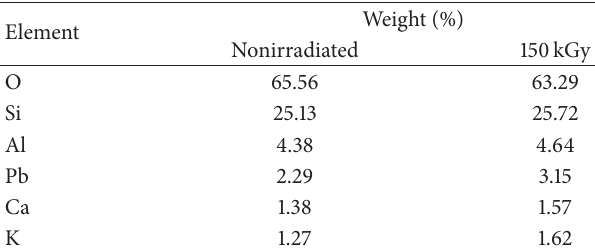
Table 7: EDS analysis of nonirradiated and irradiated minerals after the lead adsorption